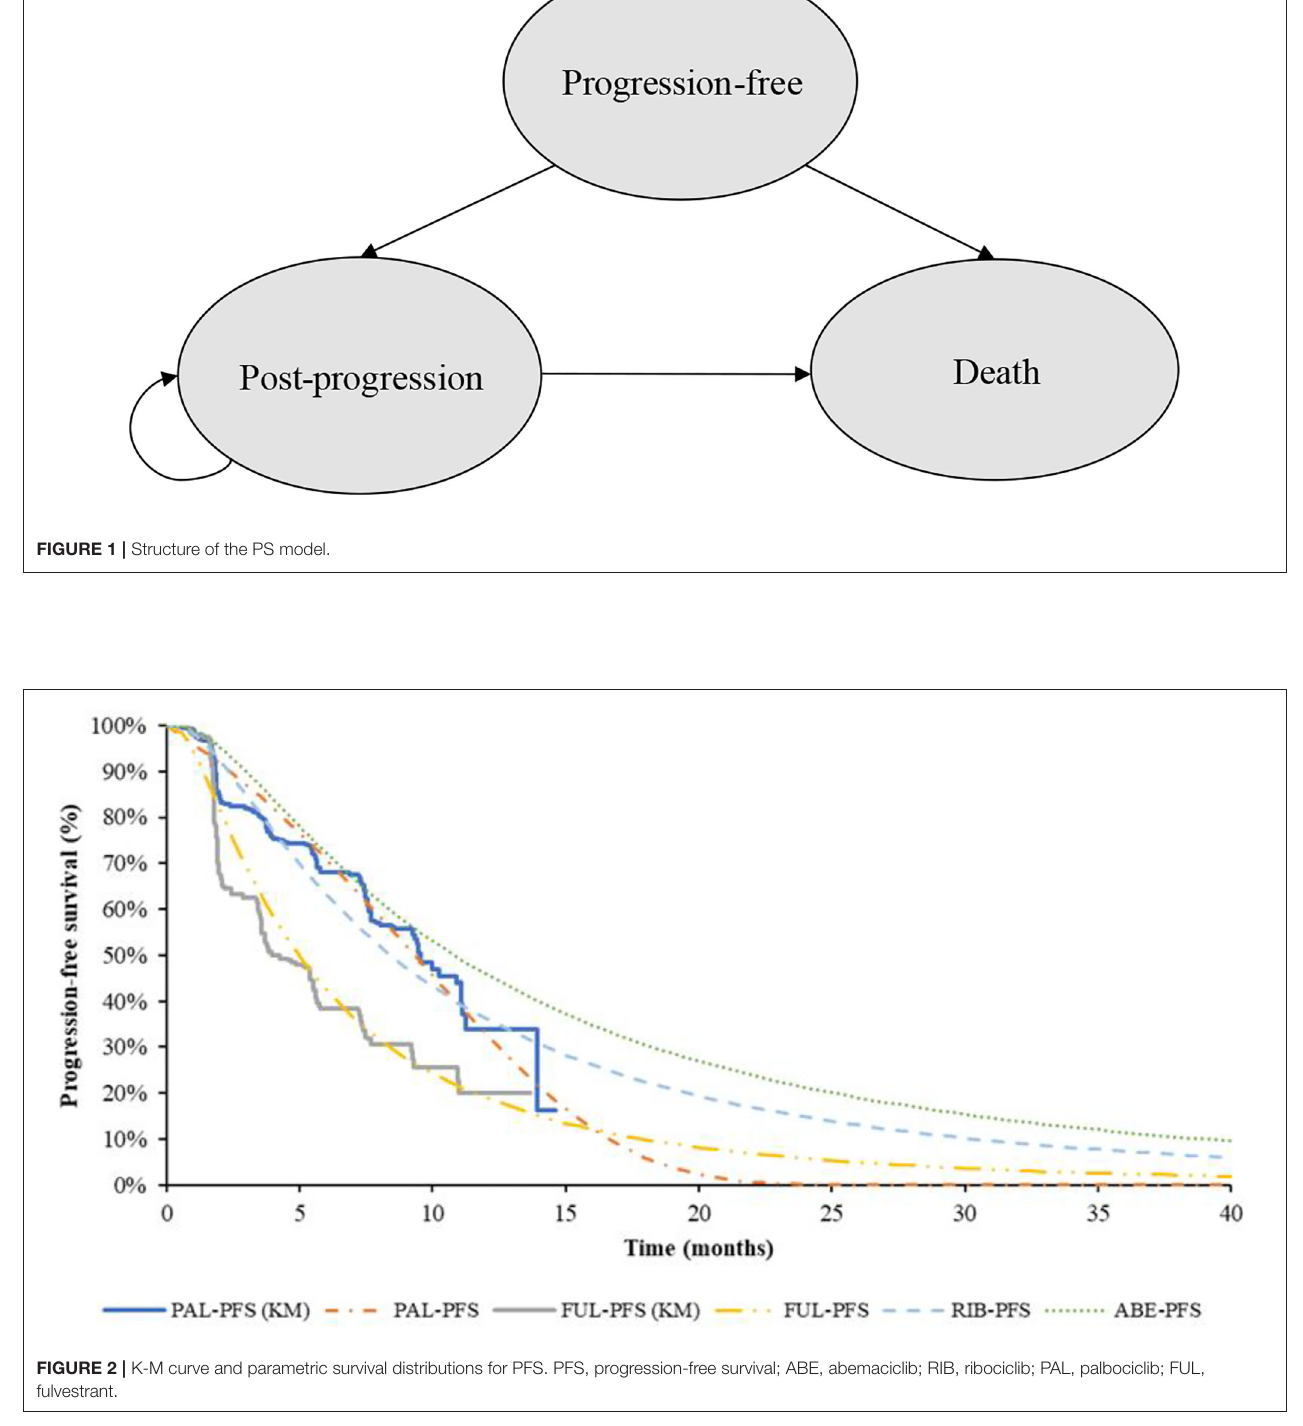
Frontiers in Medicine |